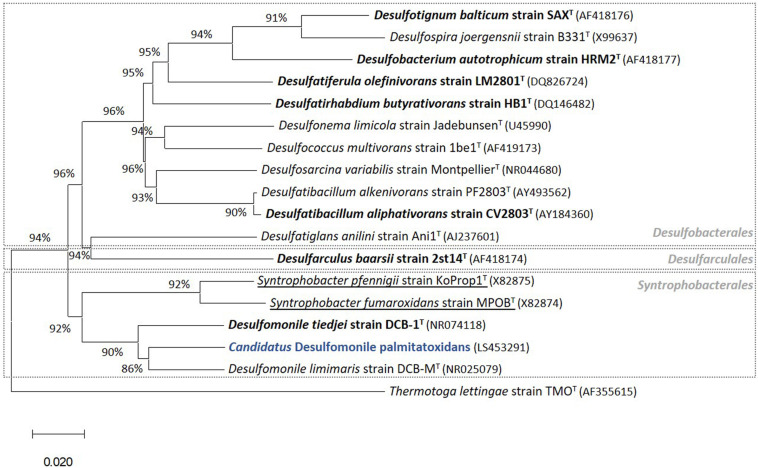
Phylogenetic tree of 16S rRNA gene sequences highlighting (in blue) the position of “Candidatus Desulfomonile palmitatoxidans” from HP culture relative to other species of the same genus, as well as selected reference sequences of SRB within the class Deltaproteobacteria. These SRB, belonging to the Desulfobacterales, Desulfarculales, and Syntrophobacterales orders, were chosen based on their capability to degrade SCFA, MCFA, and/or LCFA (Sousa et al., 2007b, 2009b, 2010). LCFA degraders are shown in bold and syntrophs are underlined. The phylogenetic tree was calculated using the MEGA X software package (Kumar et al., 2018). The evolutionary history was inferred using the Neighbor-Joining method (Saitou and Nei, 1987). The optimal tree with the sum of branch length = 0.97544146 is shown. The evolutionary distances were computed using the p-distance method (Nei and Kumar, 2000). GenBank accession numbers of 16S rRNA gene sequences are indicated in parentheses. Thermotoga lettingae strain TMOT (AF355615) was used as an outgroup. Bar, 2 % estimated difference in nucleotide sequence position.